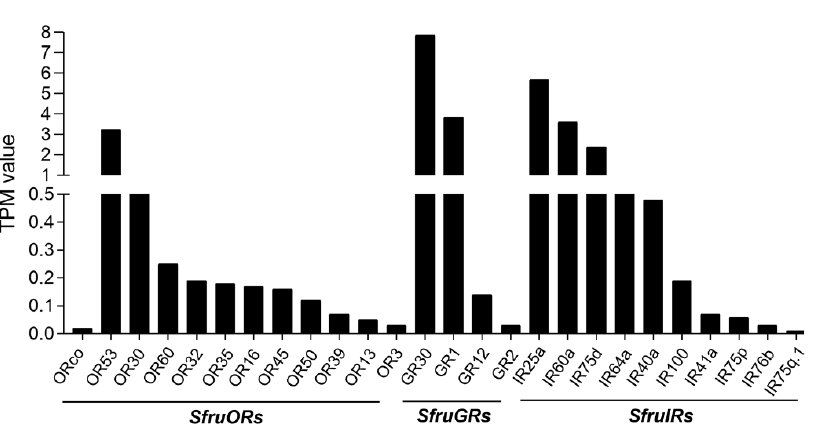
Figure 2. TPM values of candidate ORs, GRs, and IRs in the pheromone gland-ovipositor of S. frugiperda .